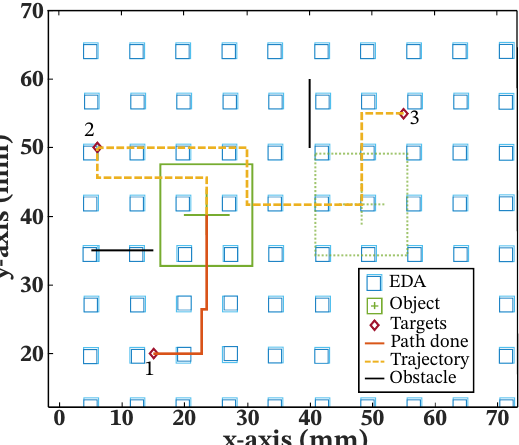
Figure 8. Interface: A pathfinding problem with 3 target points and two obstacles solved with the adapted A* algorithm and dynamic model (and a 1mm safety distance to the